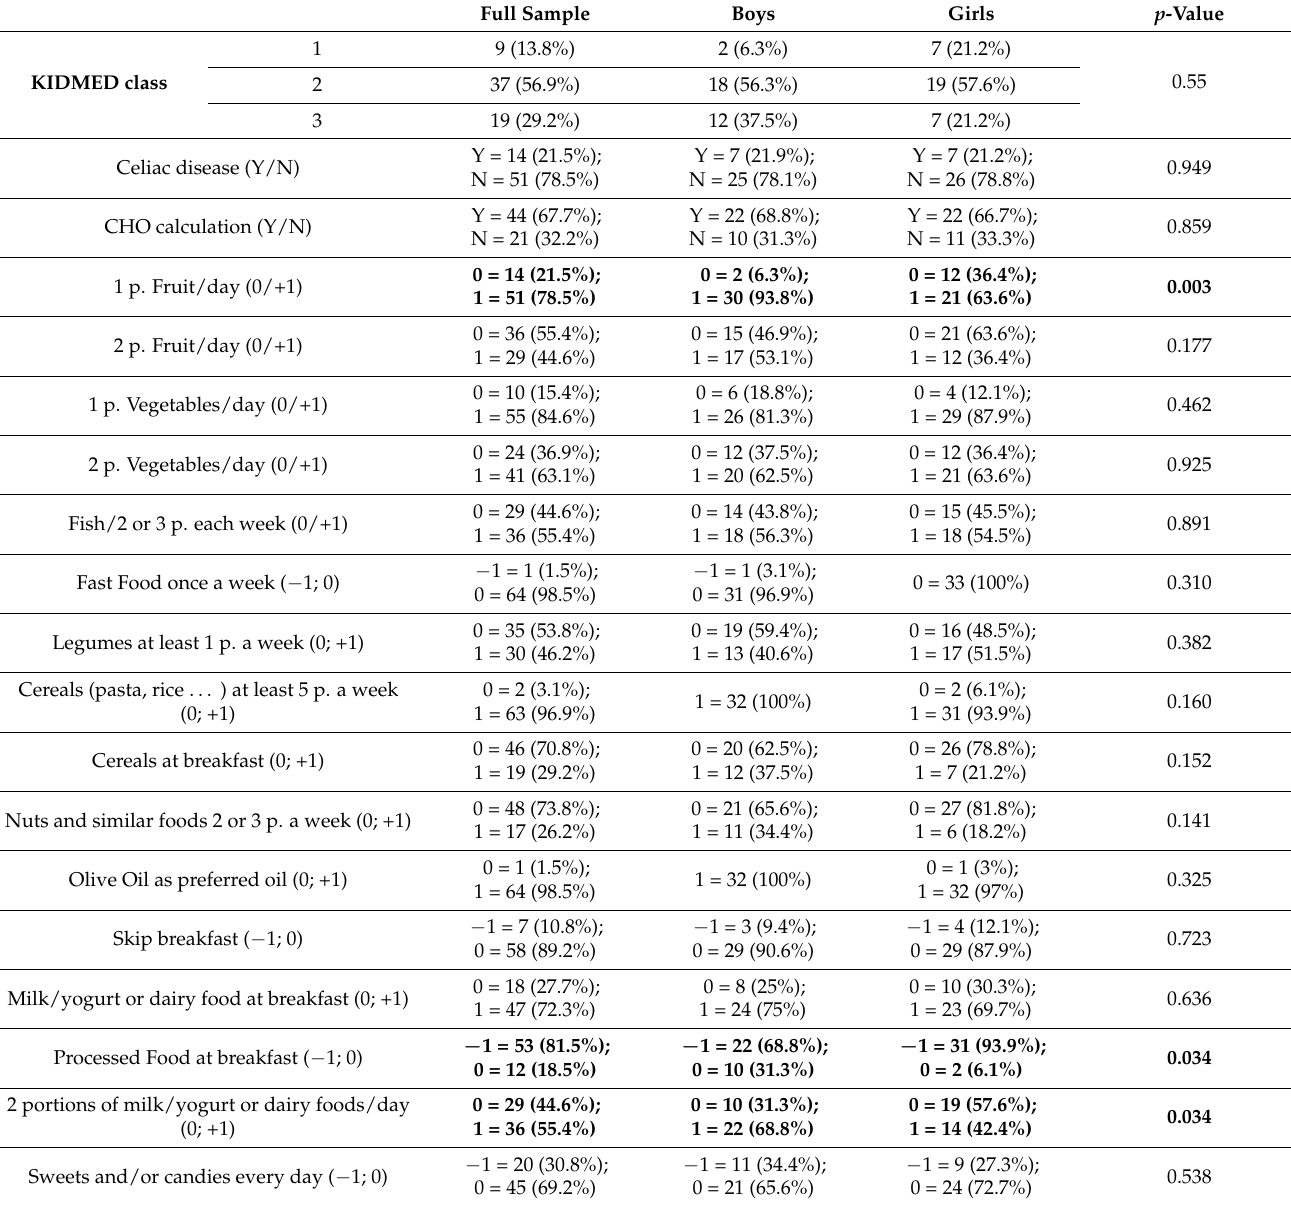
Table 2. KIDMED items and other nutrition-related statistics in the